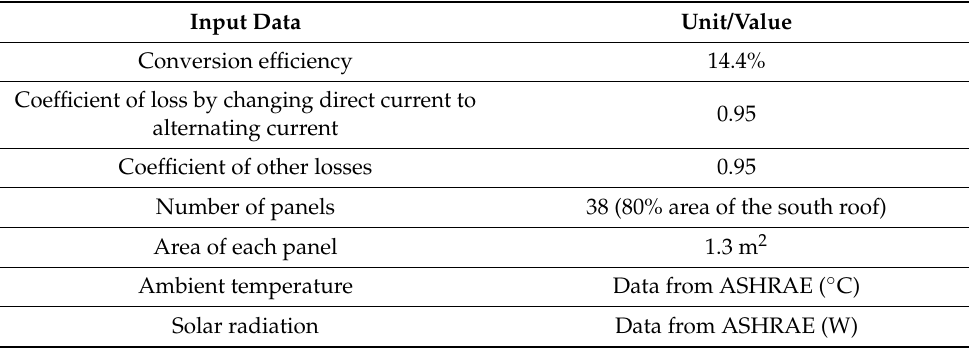
Table 8. Input parameters of the program